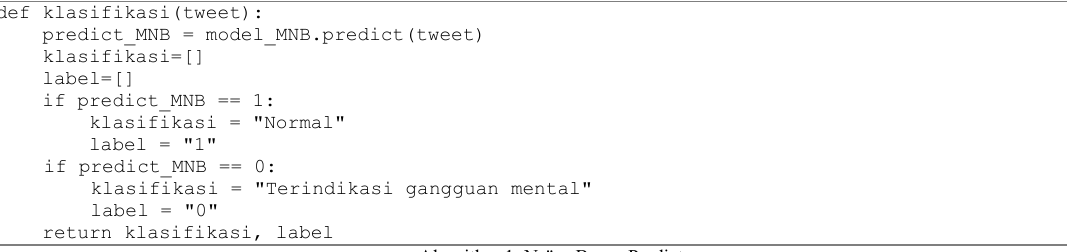
Algorithm 1. Naïve Bayes